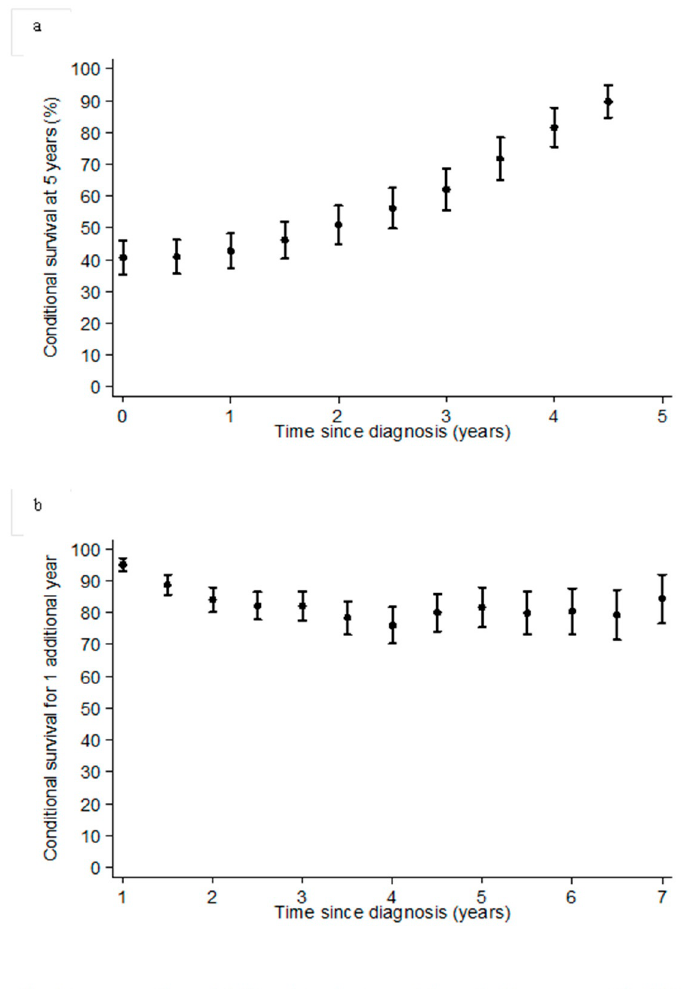
Figure 1. Conditional probability of survival at 5 years ( a ) and conditional probability of survival for one additional year ( b ) according to the time of diagnosis